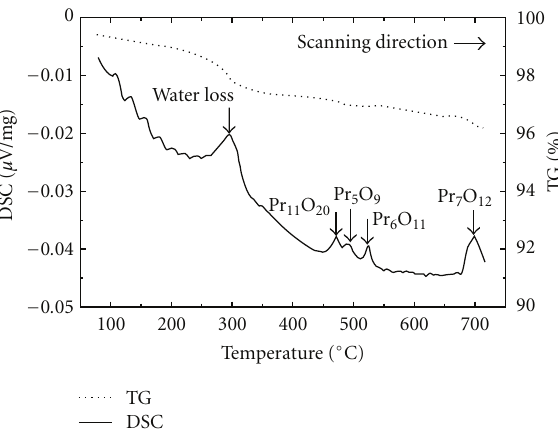
Figure 3: Lattice parameters of praseodymium oxide crystals as a function of temperature. Reproduced from J. Phys. Chem. , 1968, 72 , 4415. Copyright 1968, the American Chemical Society [5].